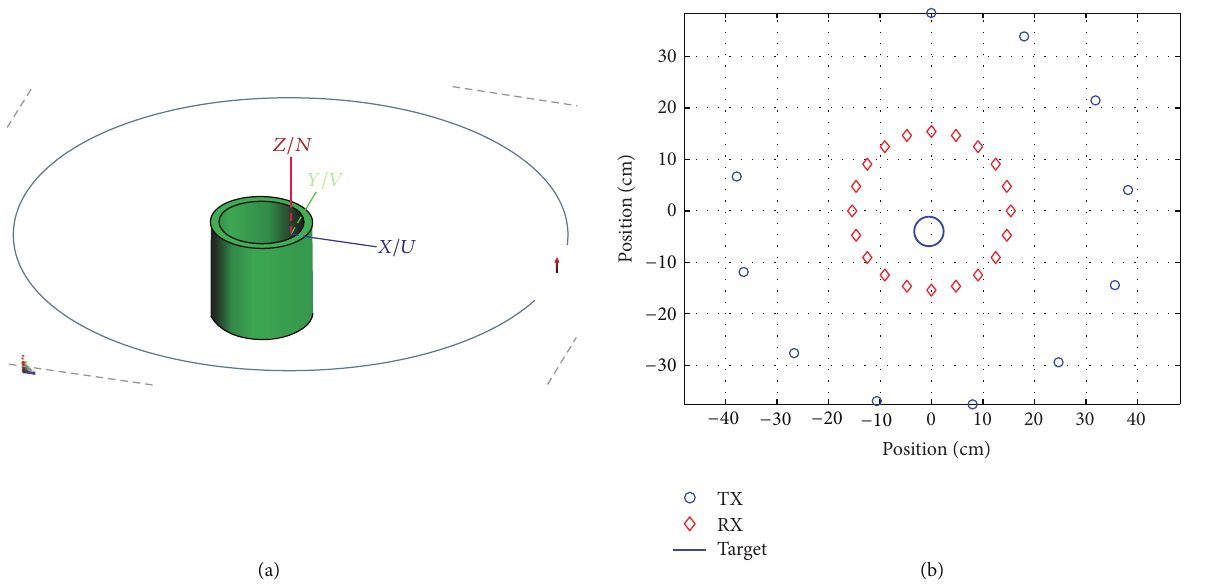
Figure 2: 3D model of the PVC pipe (a) and locations of the antennas used in the measurement